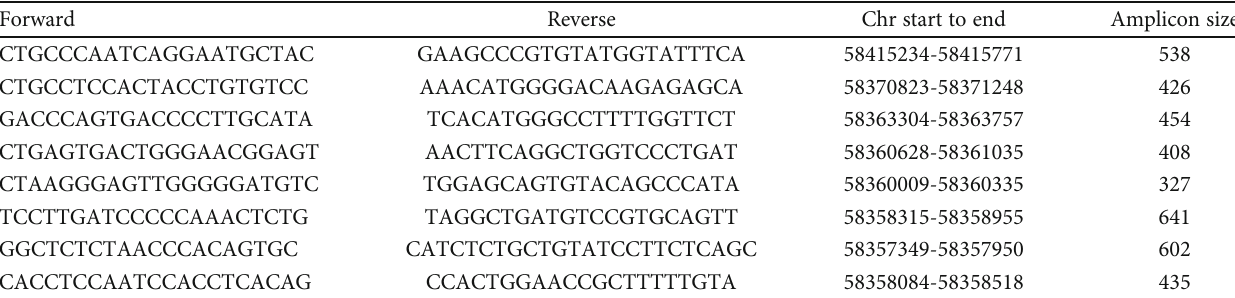
Table 2: PCR primers used for validation of RNF43